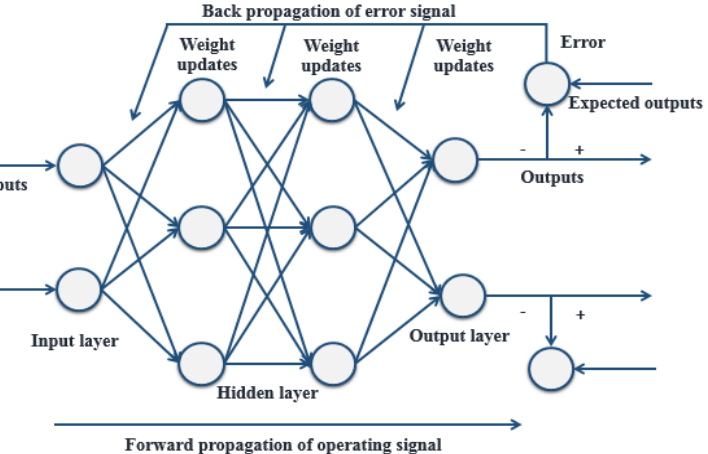
Figure 4. Sketch graph of a back-propagation (BP) artificial neural network with two hidden lay-